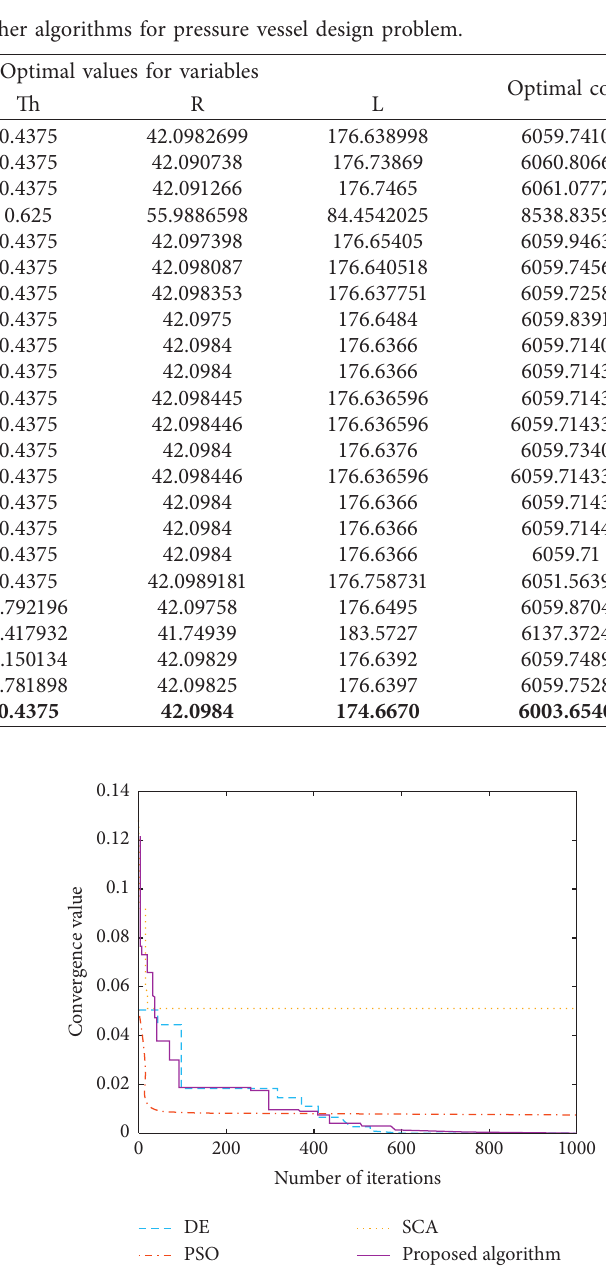
Figure 7: Convergence